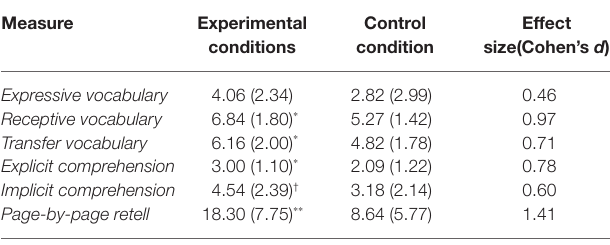
TABLE 6 | Descriptive results for experimental and control conditions; Mean (standard